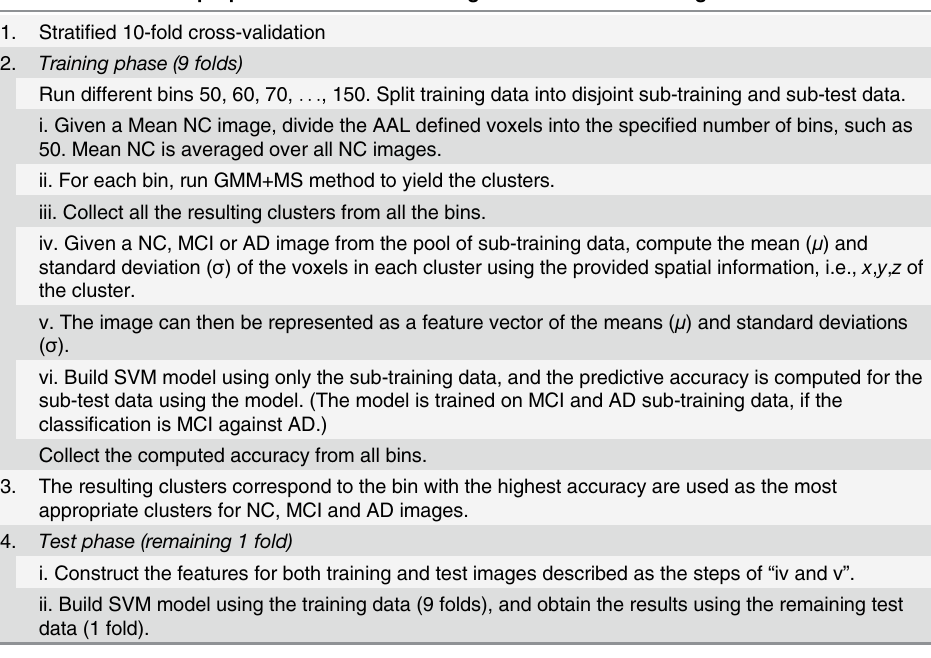
Table 3. Workflow of proposed GMM+MS clustering method on 3D PET